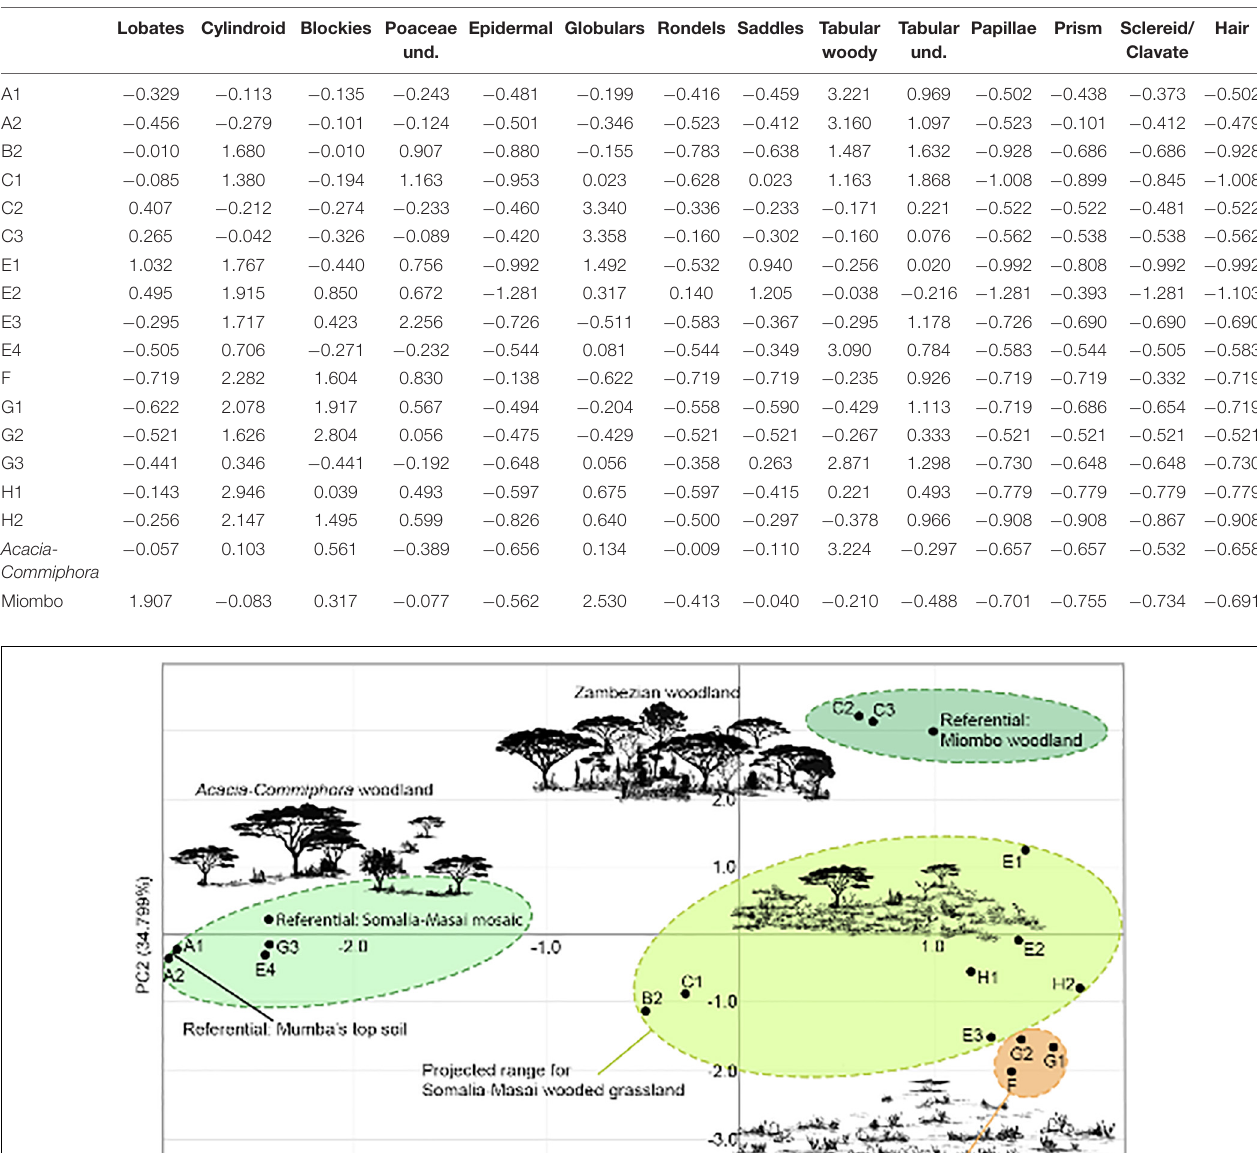
TABLE 7 | Standardized ( Z -score) for phytolith variables from Mumba and comparative, present-day baselines. Lobates Cylindroid Blockies Poaceae